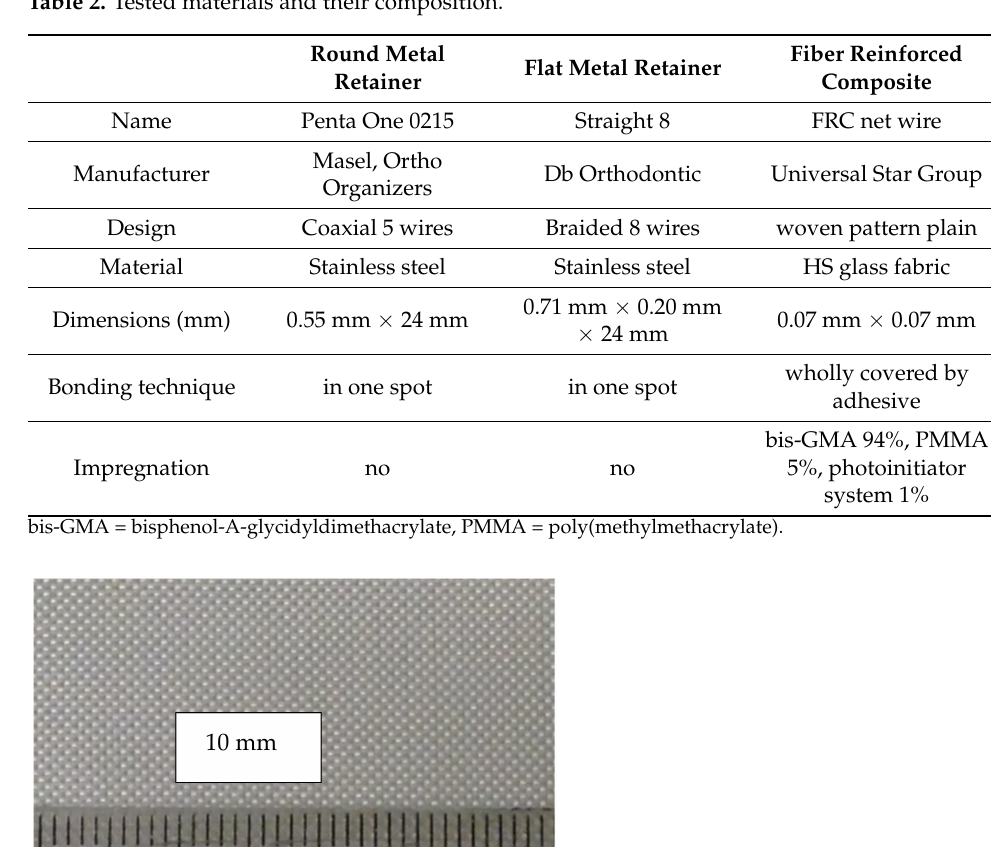
Table 2. Tested materials and their composition.